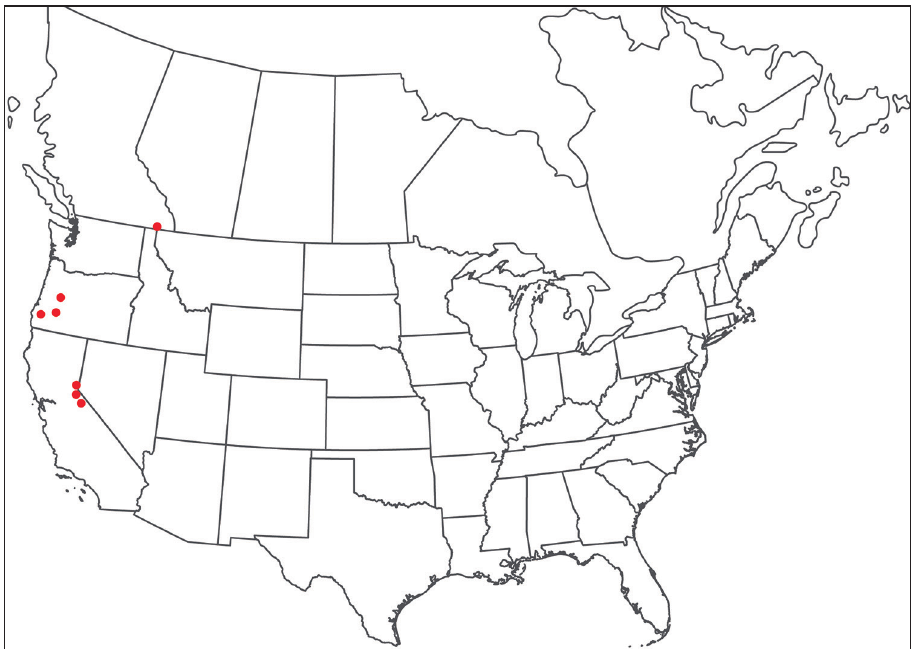
Figure 270. Torrenticola walteri sp. n.